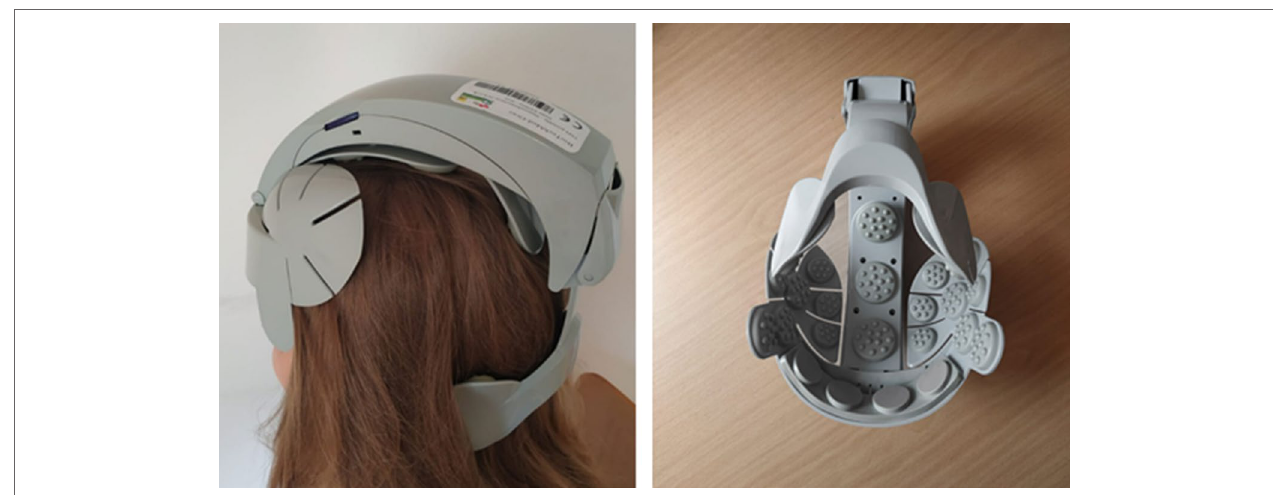
FIGURE 1 | Sham device for transcranial magnetic stimulation (sTMS).